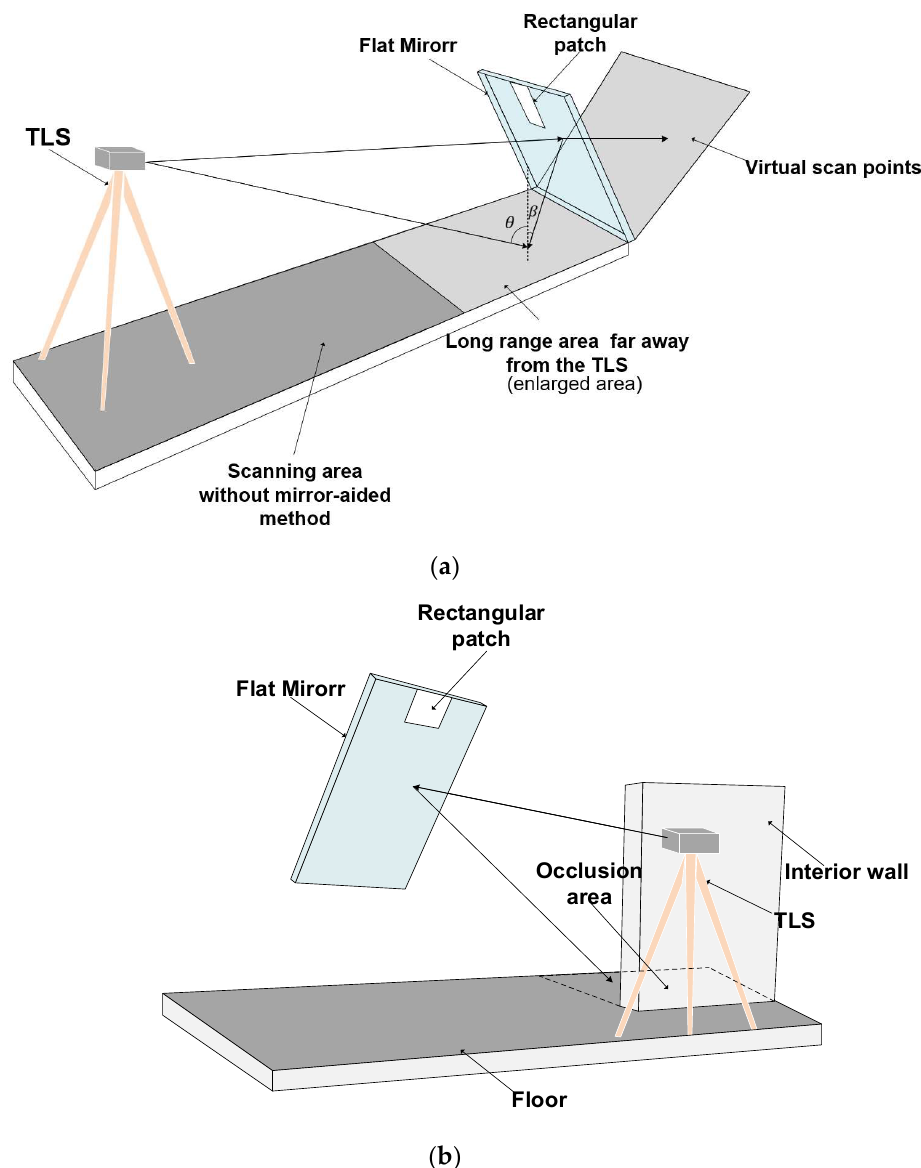
Figure 3. Illustration of the two hypotheses: ( a ) hypothesis 1—the proposed mirror-aided technique may increase scan coverage and inspection accuracy; and ( b ) hypothesis 2—the proposed mirror-aided technique may enable scanning of occlusion areas.